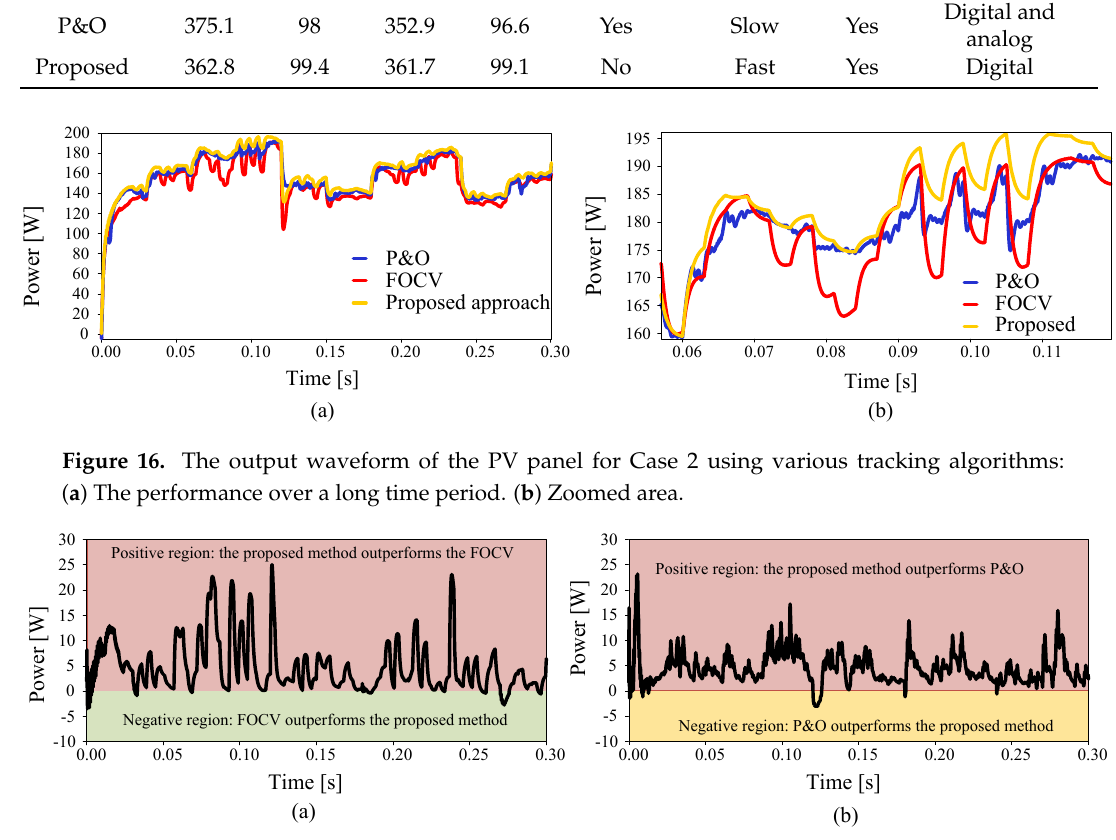
Figure 17. Case 2: comparison between the proposed method with ( a ) the FOCV method and ( b ) the P&O